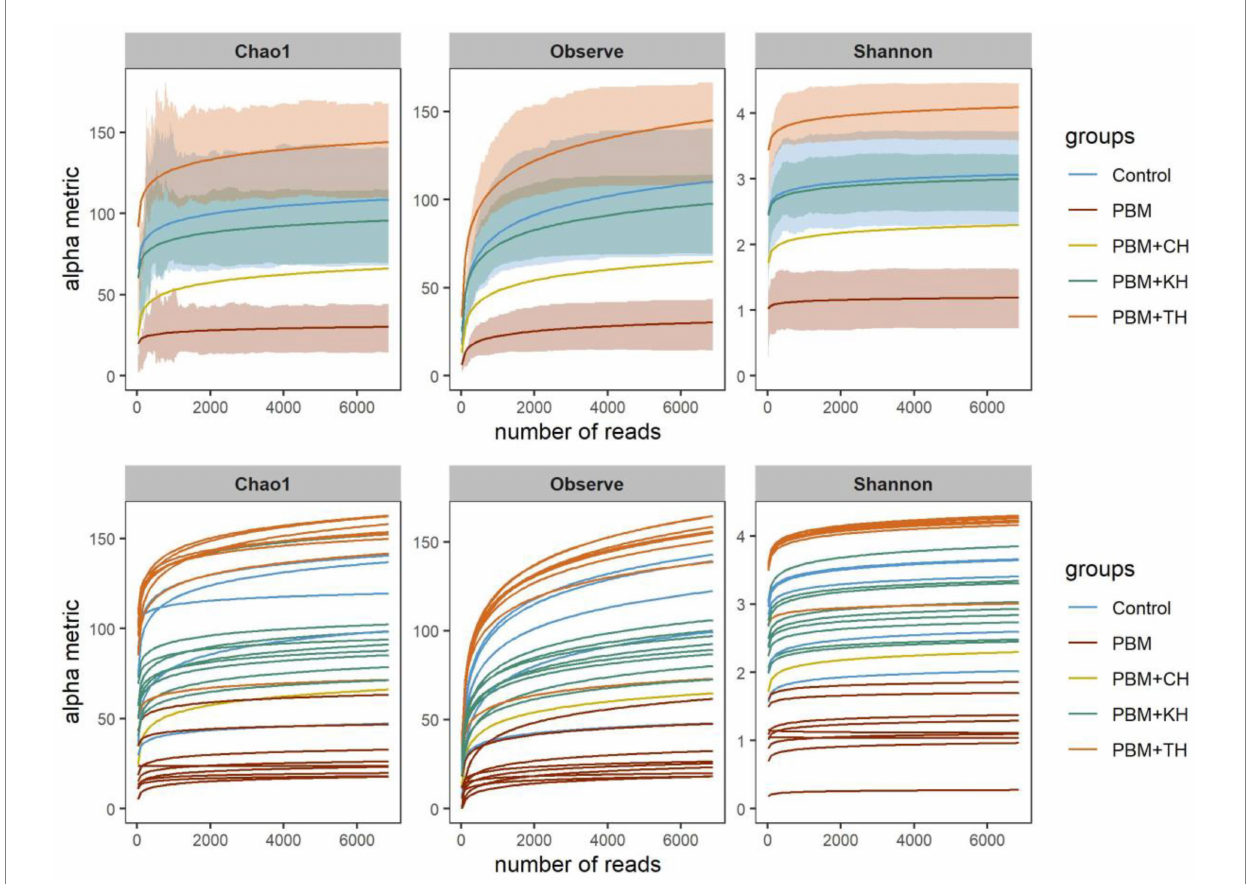
FIGURE 2 Rarefaction curve showing the depth and saturation level of sequences for a specific group (top) and individual (bottom) sample. Rarefied data was used to generate the rarefaction curve where X-axis represents the number of reads (rarefied) and Y-axis is the values for specific alpha-diversity